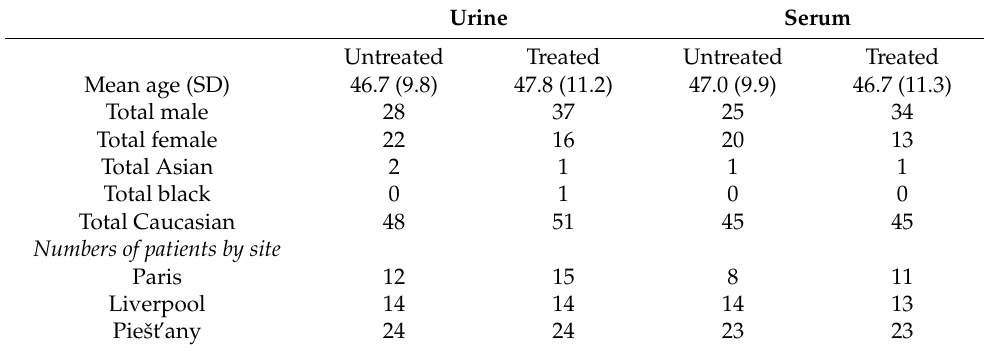
Table 1. Patient demographics and summary of patient numbers per trial arm and study